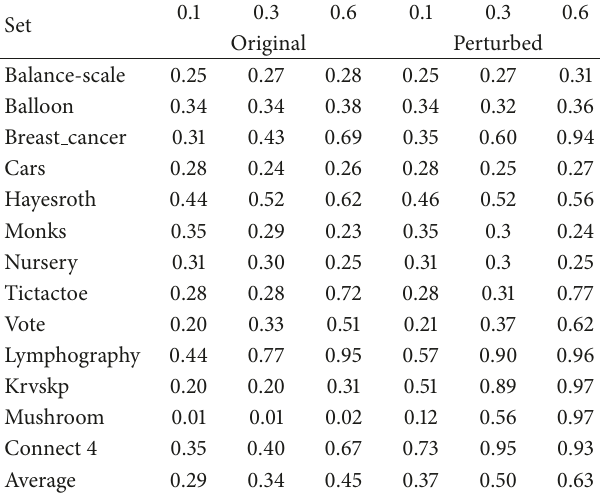
Table 8: Emergence rate in all